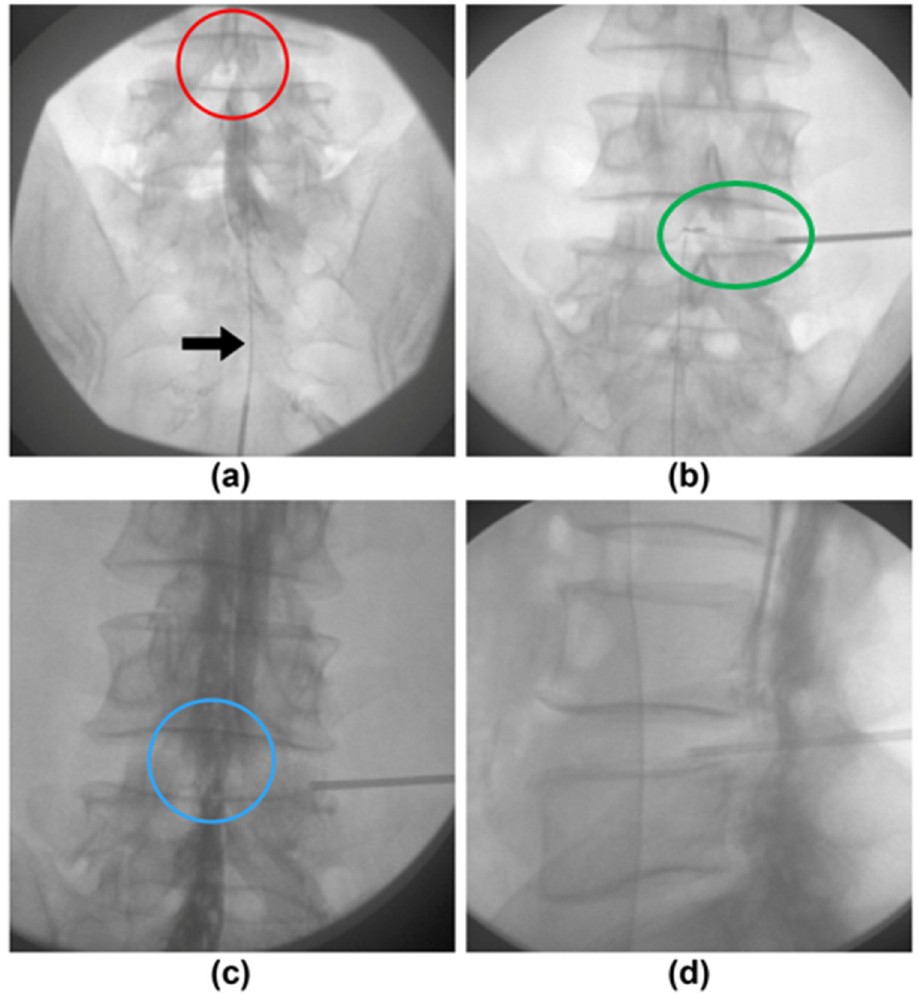
Figure 1. ( a ) Fluoroscopic anterior-posterior view of the pre-percutaneous plasma disc decompression (pre-PPDD). The filling defect was present at lumbar 4/5 disc level. ( b ) Fluoroscopic anterior-posterior view of the during-PPDD. ( c ) Fluoroscopic anterior-posterior view of the post-PPDD. The resolution of filling defect was verified. ( d ) Fluoroscopic lateral view of the post-PPDD. The 17-gauge spinal cannula was positioned at the junction of the annulus and nucleus Arrow, ABEL catheter; Red circle, the contrast media does not spread well above the involved disc level; Green circle, the into-LB was situated 6 o’clock position within the nucleus; Blue circle, the contrast media sufficiently spread above the involved disc level.